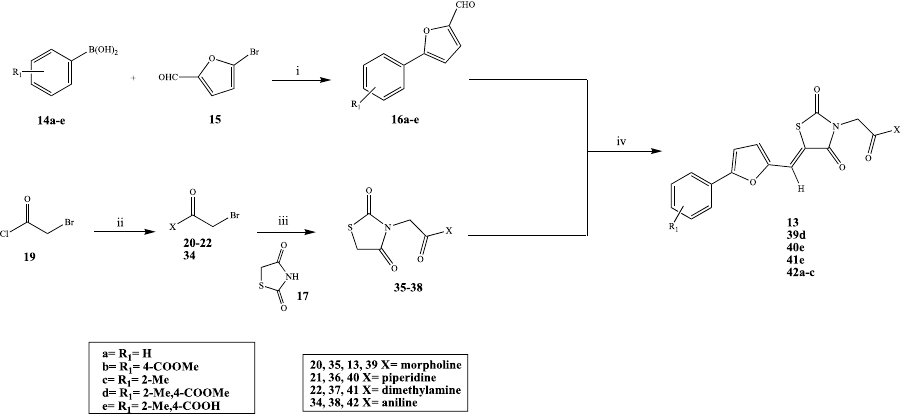
Figure 9. General synthetic procedure followed for the preparation of 13, 39d, 40e, 41e, 42a-c. (i) Na 2 CO 3 , Pd(PPh